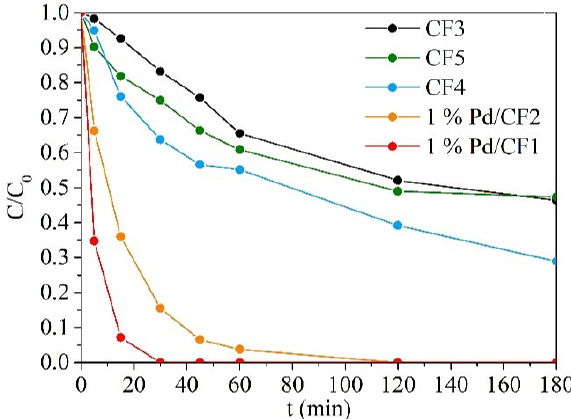
Figure 5. Dimensionless concentration of BrO 3 − during catalytic experiments using Pd-CFs compos- ite